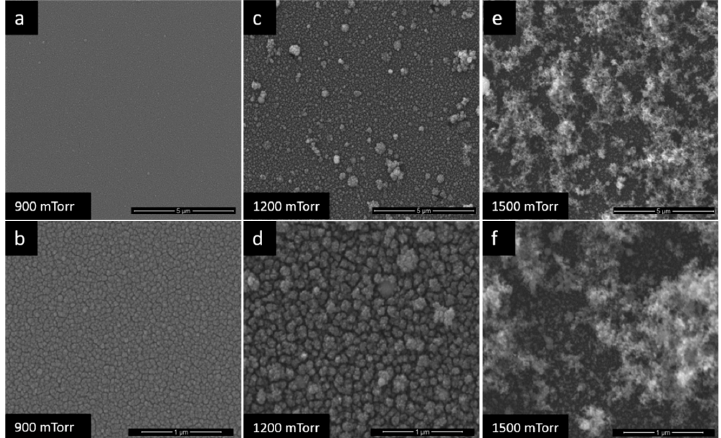
Figure 5. SEM images of the Pd films at ( a ) and ( b ) − 900 mTorr, ( c ) and ( d ) − 1200 mTorr, ( e ) and ( f ) − 1500 mTorr.